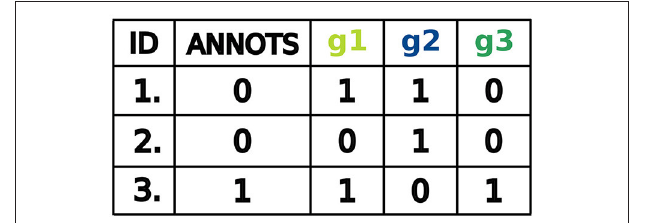
FIGURE 3 | Example data set for 3 samples: 2 negative and 1 positive.